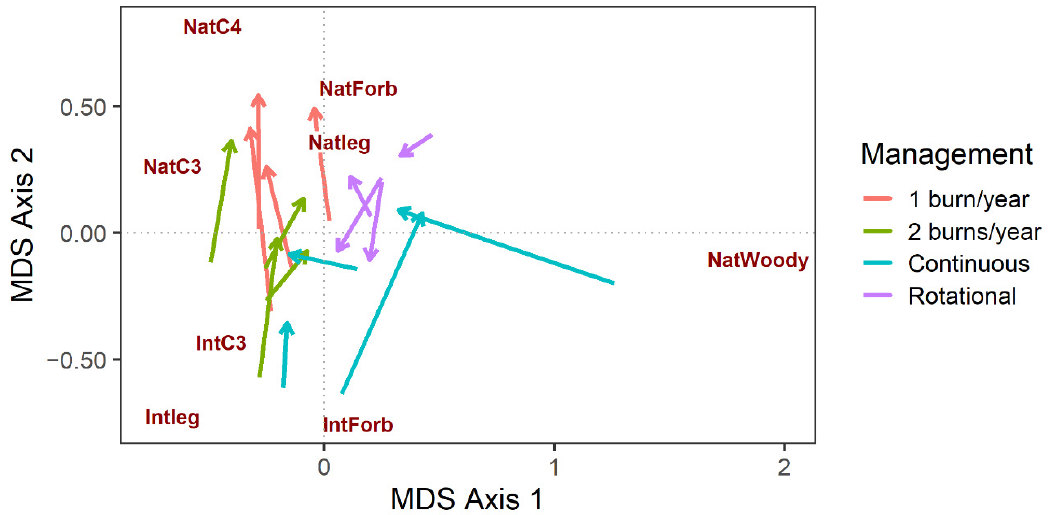
Figure 4. Nonmetric dimensional scaling ordination of vegetation functional groups in patch-burn treatments with one burn/year, two burns/year, continuous grazing, and modified rotational grazing systems at the Central Grasslands Research Extension Center in Streeter, ND. Arrows represent the trajectory of each pasture centroid from the beginning of treatment implementation until treatment completion, with arrow length indicating the magnitude of change. Nat = Native, Int = Introduced, Leg = Legume.